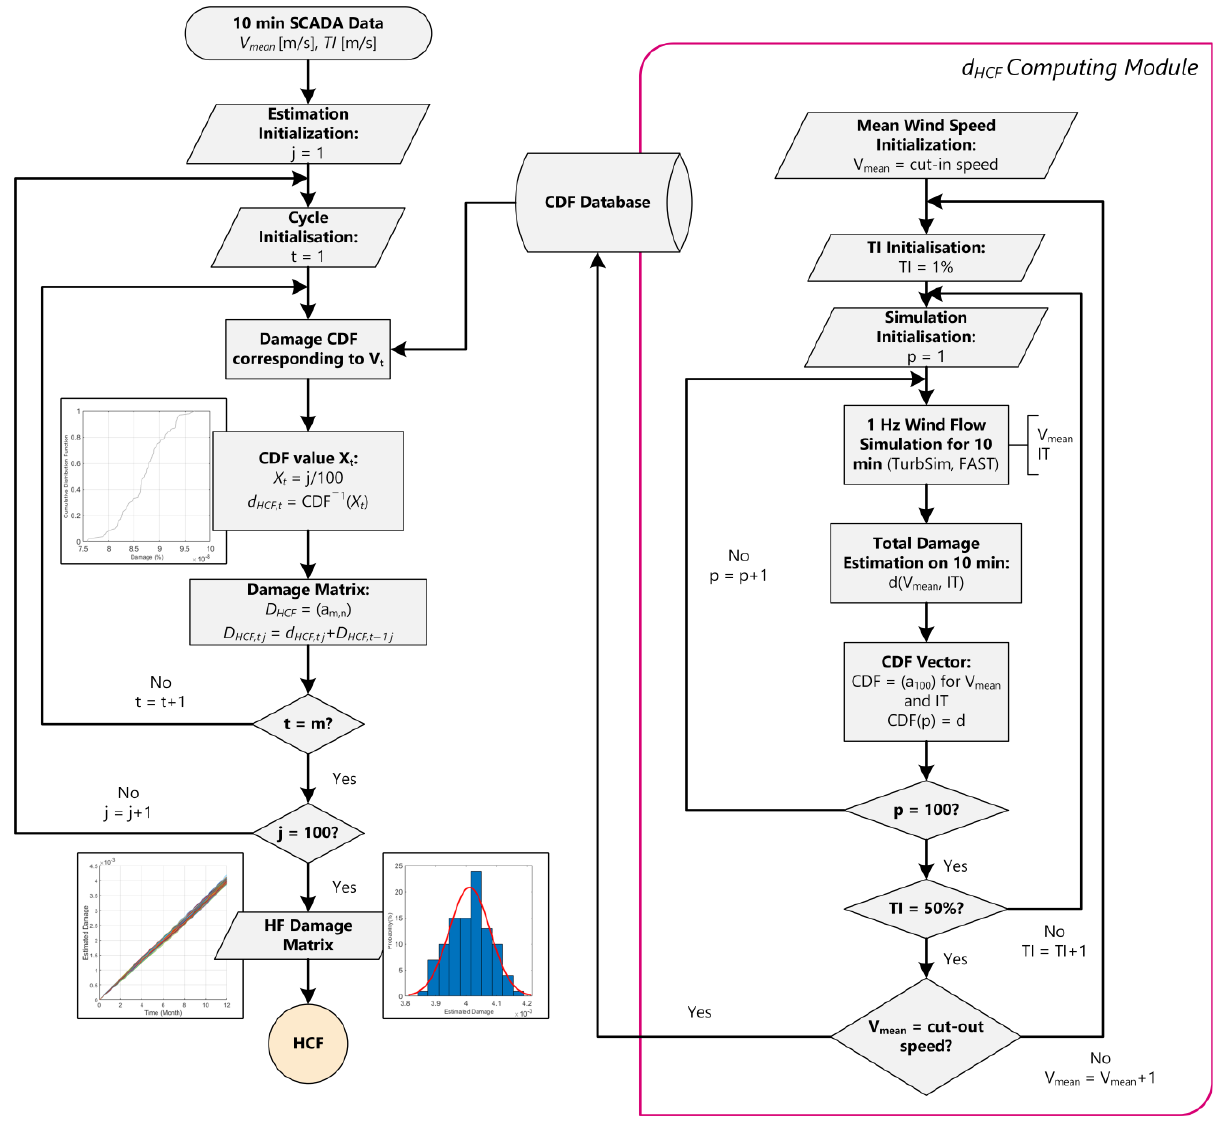
Figure 9. Flowchart showing the process leading to the estimation of the HCF damage from the SCADA